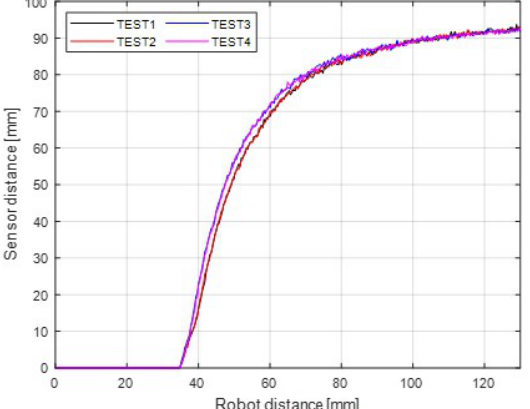
Figure 16. The proximity values recorded for the stomach during the movement of the robot in four tests.